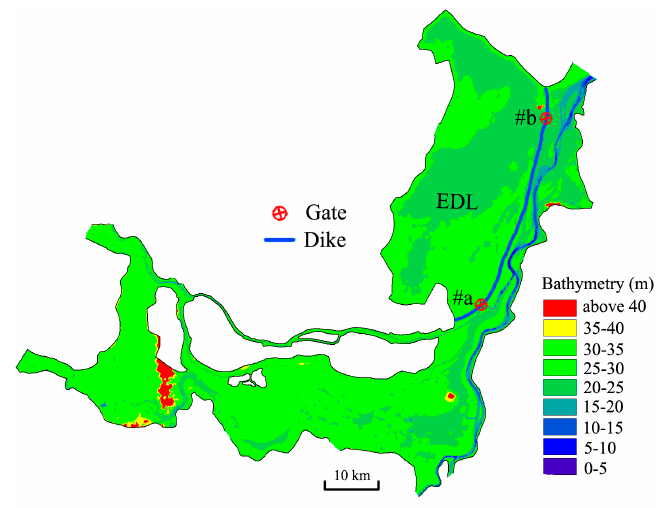
Figure 9. The layout of the IFCS in East Dongting Lake. Table 5. The operating water level of the gate in East Dongting Lake (unit: m).